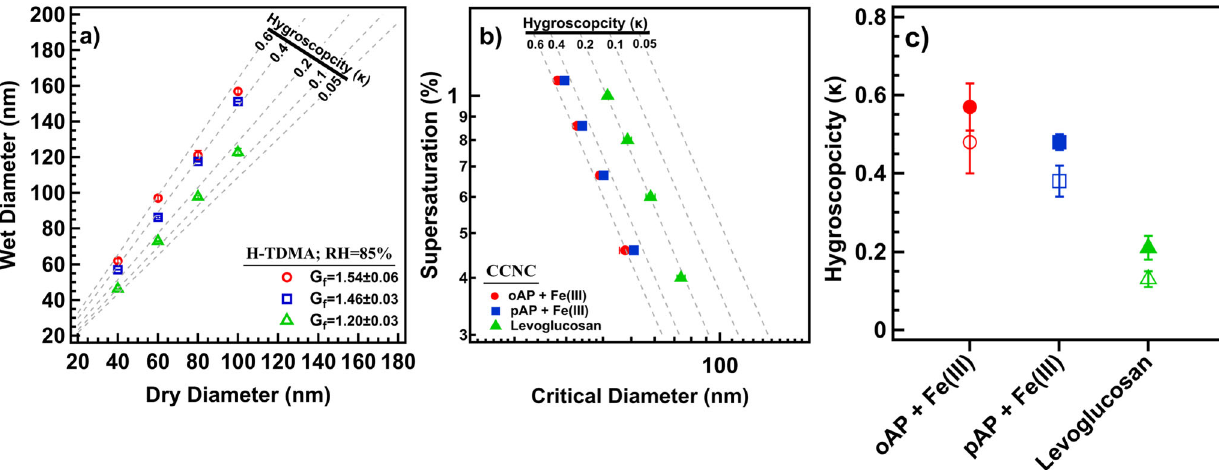
Fig. 4 The cloud condensation nuclei activity of oligomers from the ortho -aminophenol ( o AP) + Fe(III) reaction (red circles), para -aminophenol ( p AP) + Fe(III) reaction (blue squares), and levoglucosan (green triangles). a The wet diameter growth versus initial dry diameter of particles exposed to a subsaturated environment (85% RH) from H-TDMA measurement. The average G f for each material is also reported. Gray dashed lines show theoretical κ -Köhler values. b The average critical diameter versus supersaturation from CCNC measurement (closed symbols). Gray dashed lines show theoretical κ - Köhler values. A decrease in critical diameter size at a constant supersaturation indicates an increase in CCN and droplet activity. c Summary of Köhler theory hygroscopicity parameter, κ , acquired from CCNC (closed symbols) and H-TDMA (open symbols) measurements. Each point represents an average of 10 points. Error bars show standard